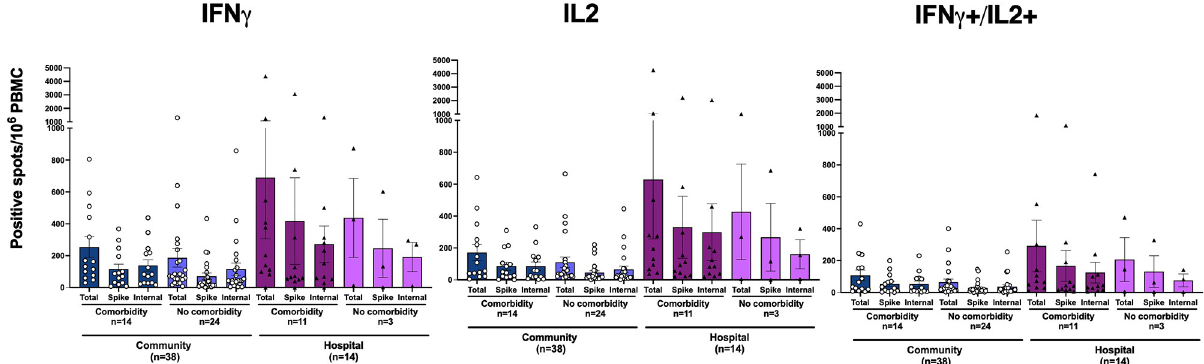
Fig 4. SARS CoV-2 specific T-cell responses by comorbidity. The SARS-CoV-2 specific T-cell responses in peripheral blood mononuclear cells (PBMC) were determined by IFN- γ + , IL-2 + , and IFN- γ + + IL-2 + in FluroSPOT in community and hospitalized patients who were SARS-CoV-2 confirmed, rt-PCR positive. The results are plotted according to the presence of comorbidities or no comorbidities. Each symbol represents the SARS-CoV-2 IFN- γ /IL-2 response (spot forming units (SFU) per 1 × 10 6 cells) after stimulation with virus spike antigen. The circle symbol represents community dwelling patients, and the triangle represents hospitalized patients. The horizontal bars represent the mean T-cell response for each time point ± standard error of the mean. Statistical significance was tested by the non-parametric Kruskal-Wallis multiple comparisons test (P < 0.05), and no significant difference was found.